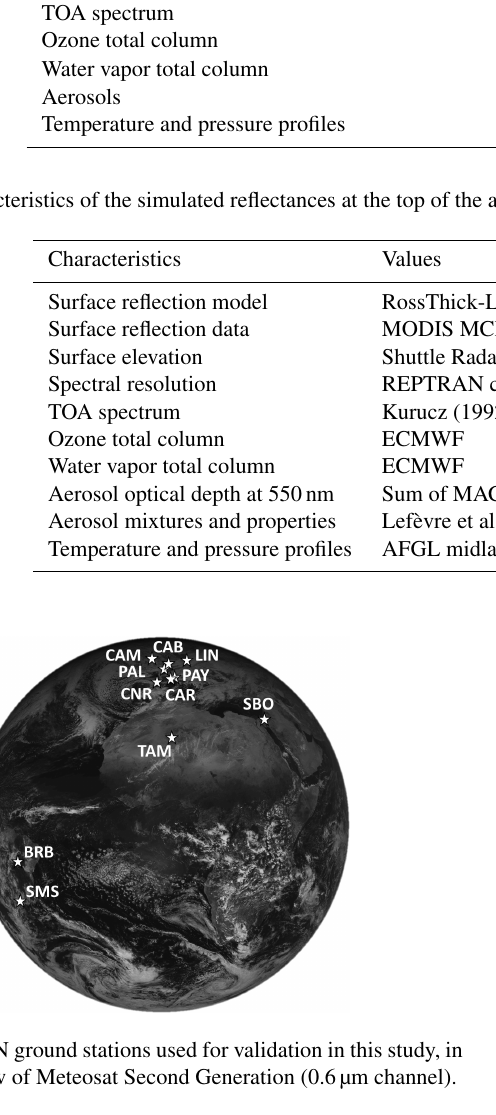
derived from the imagery of the SEVIRI sensor and are pro- duced by a Heliosat method: a modified version of Heliosat- 2 for HC3v5 (Qu et al., 2014) and Heliosat-4 for CAMS- RAD. Both products and their descriptions are provided